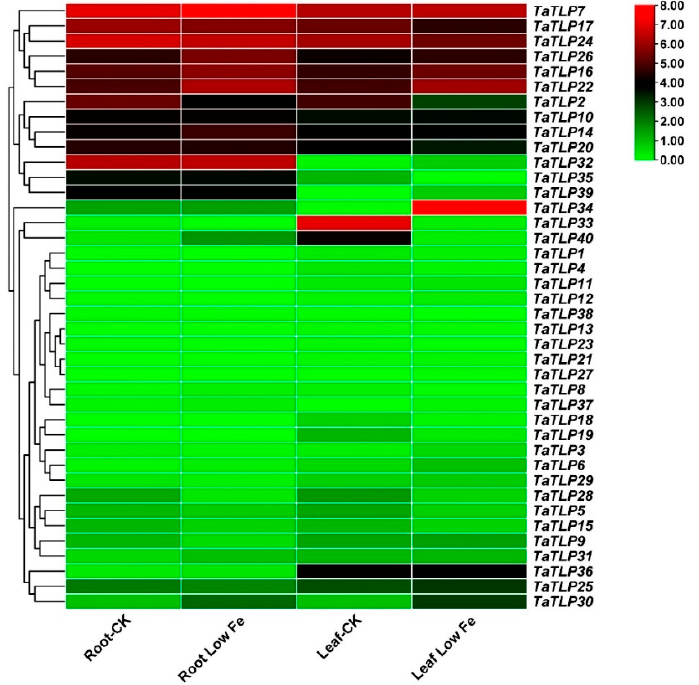
Figure 9. Heatmap representing expression analysis of TaTLP genes in wheat under iron deficiency stress.